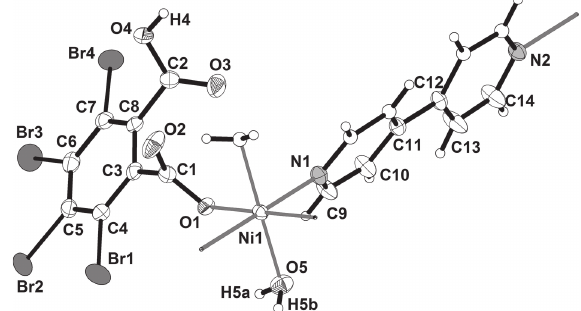
Table 1: Data collection and